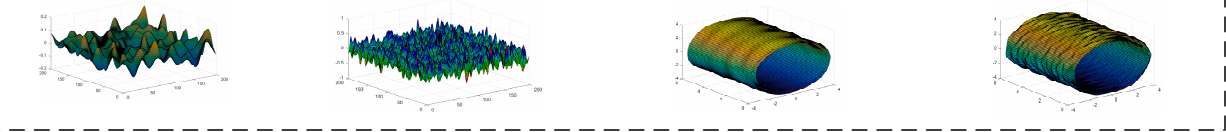
Figure 2. Overall Outline of modeling geometrical topography of the assembly interface.